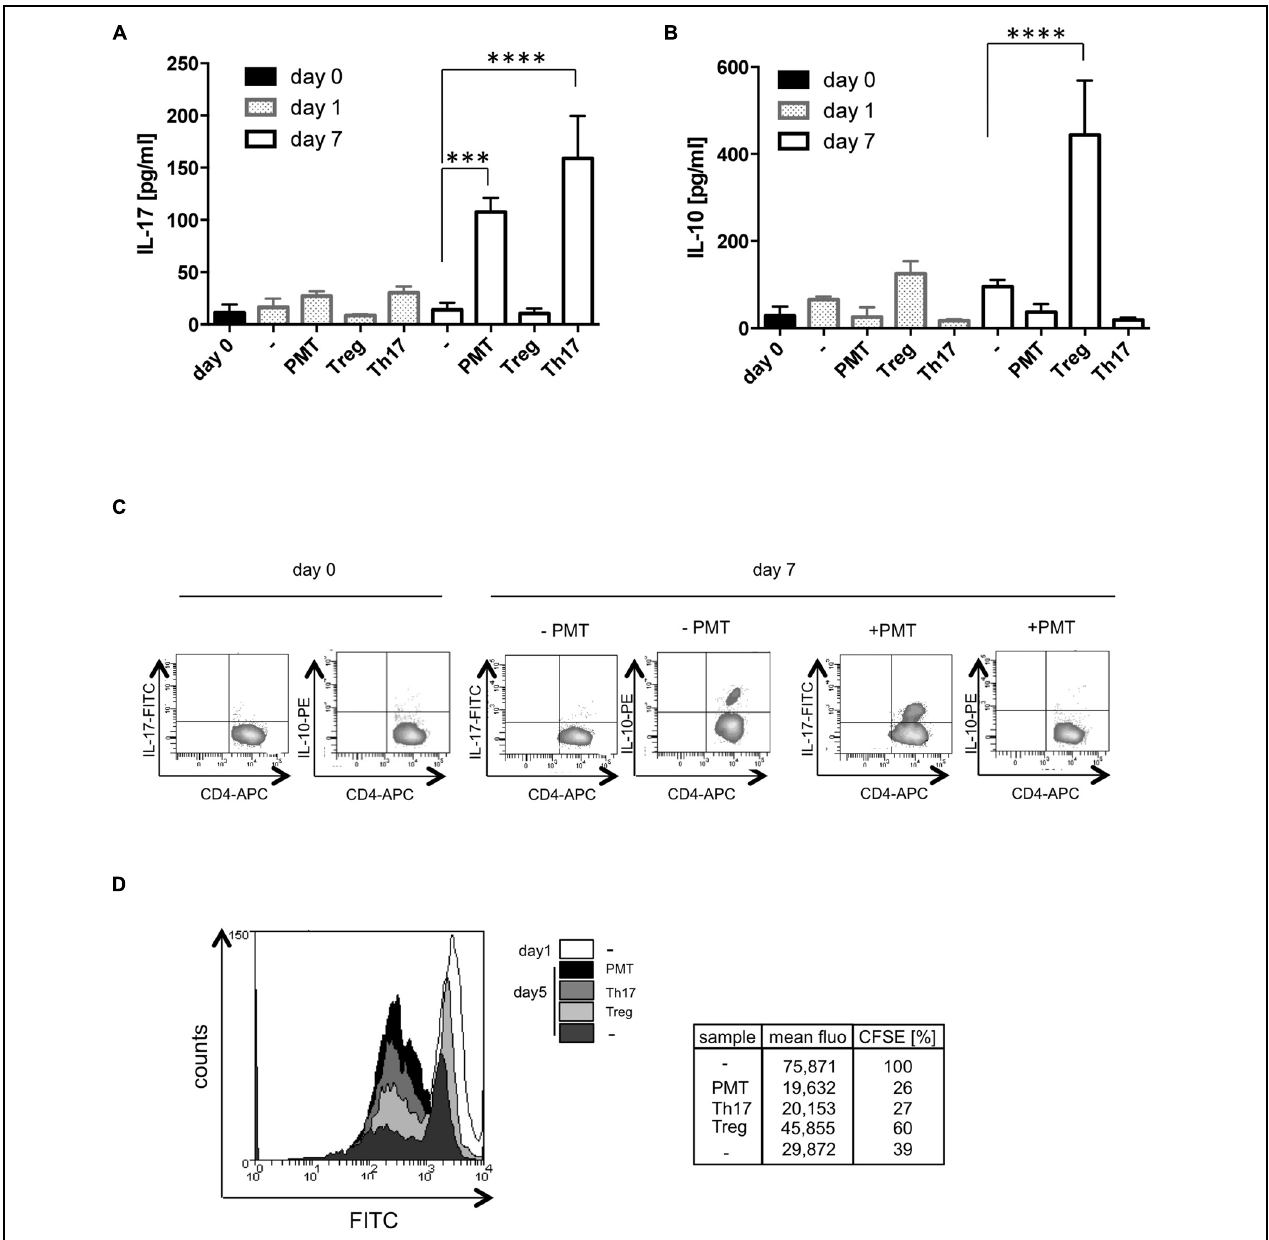
FIGURE 4 | PMT mediates a Th17 phenotype. CD3/CD28-activated Th cells were stimulated with PMT for the indicated time points. In (A) IL-17A and (B) IL-10 ELISAs were performed (mean ± SD, n = 3). Statistical significance of the produced cytokine was compared to the value obtained on day 0 using two-sided